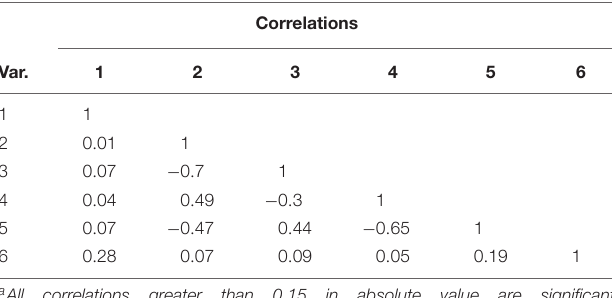
TABLE 6 | Loadings for men’s and women’s socioemotional reward and cost items in the main study (initial N = 182 couples). a